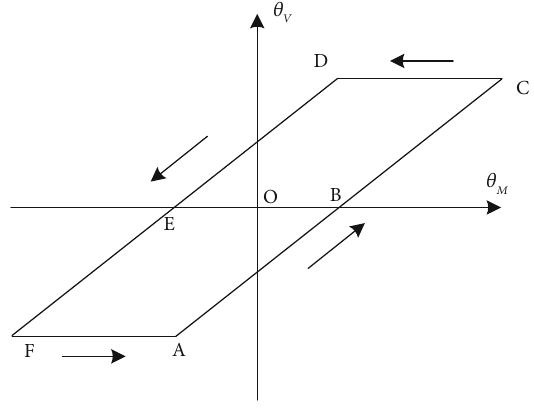
Figure 4: Hysteretic model of